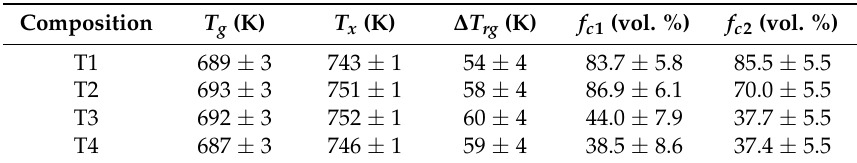
Table 1. Values of T g , T x , and ∆ T rg for the melt-spun ribbons (recorded at 20 K/min heating rate) and the corresponding volume fractions of crystals f c 1 and f c 2 of the as-cast rods as determined from DSC measurements and optical microscopy,